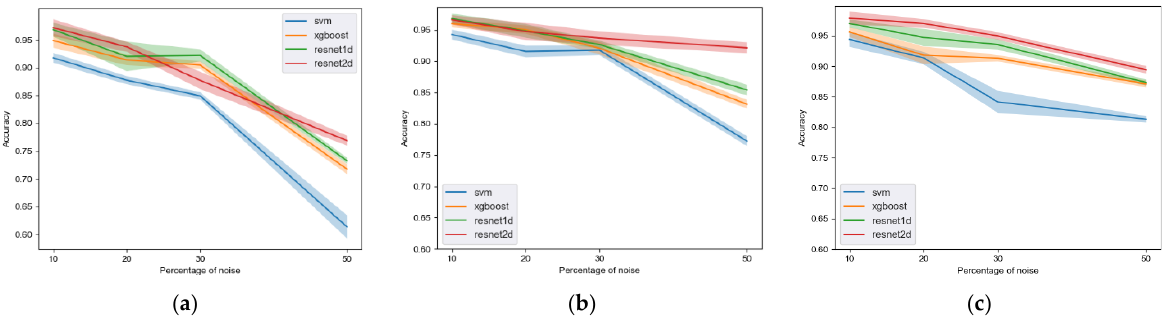
Figure 2. Performance of three classifiers according to levels of label noise in the training data. ( a ) Random flipping. ( b ) Good-to-bad flipping. ( c ) Bad-to-good flipping. Table 2. Mean accuracy values in relation to an increase in label noise in the training data.